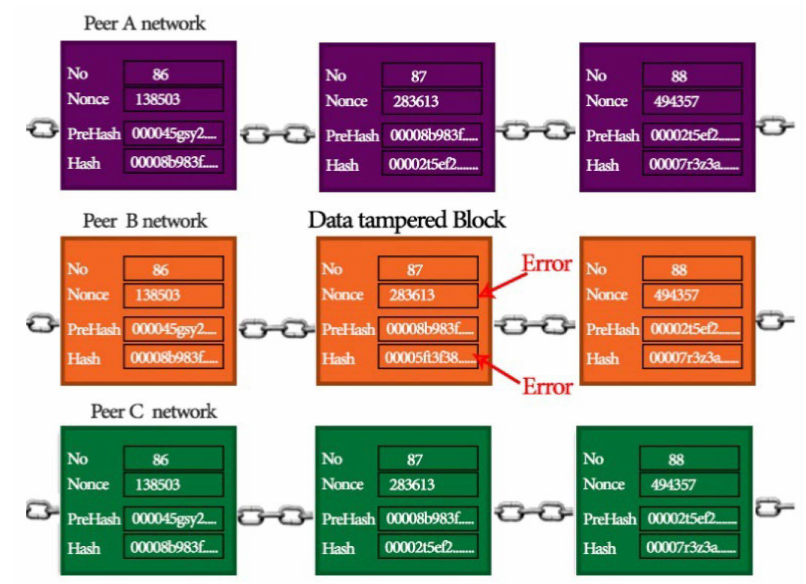
Figure 11. After being tampered with, the 87th block data.